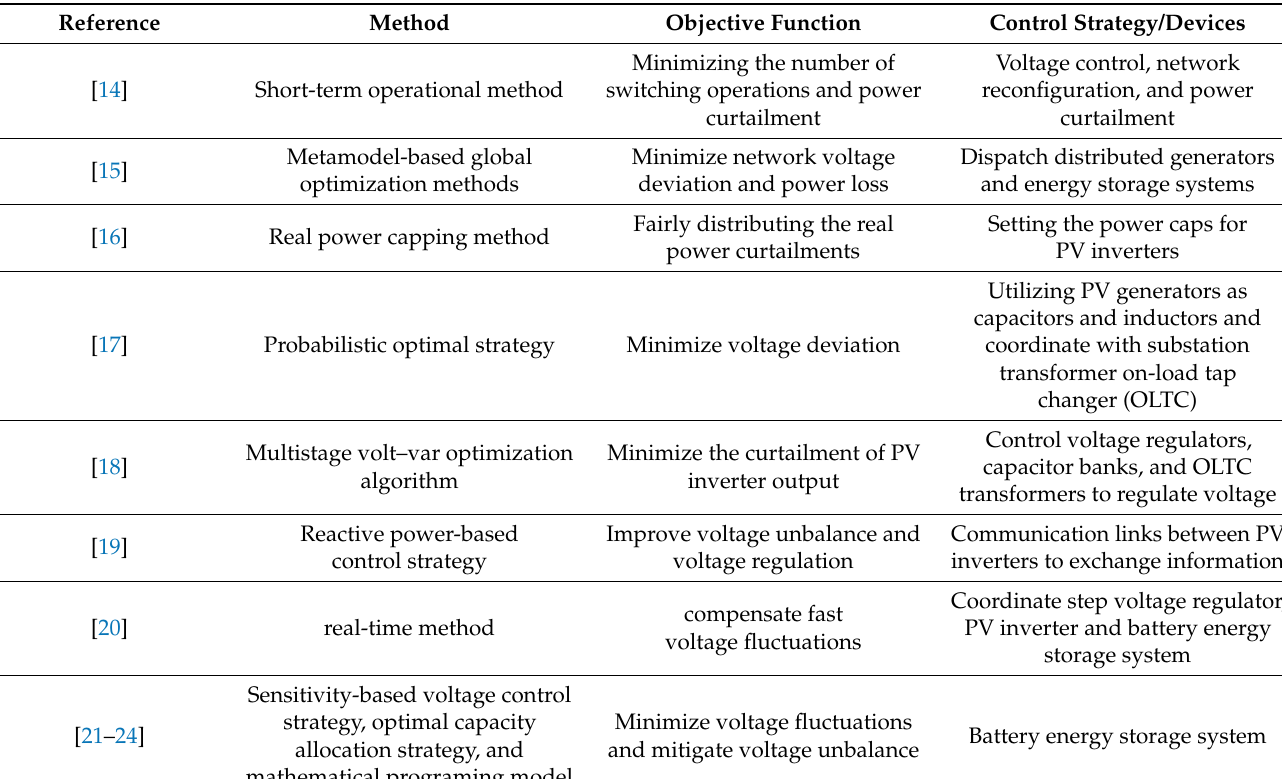
Table 1. The proposed method, objective function, and control strategy/device of related